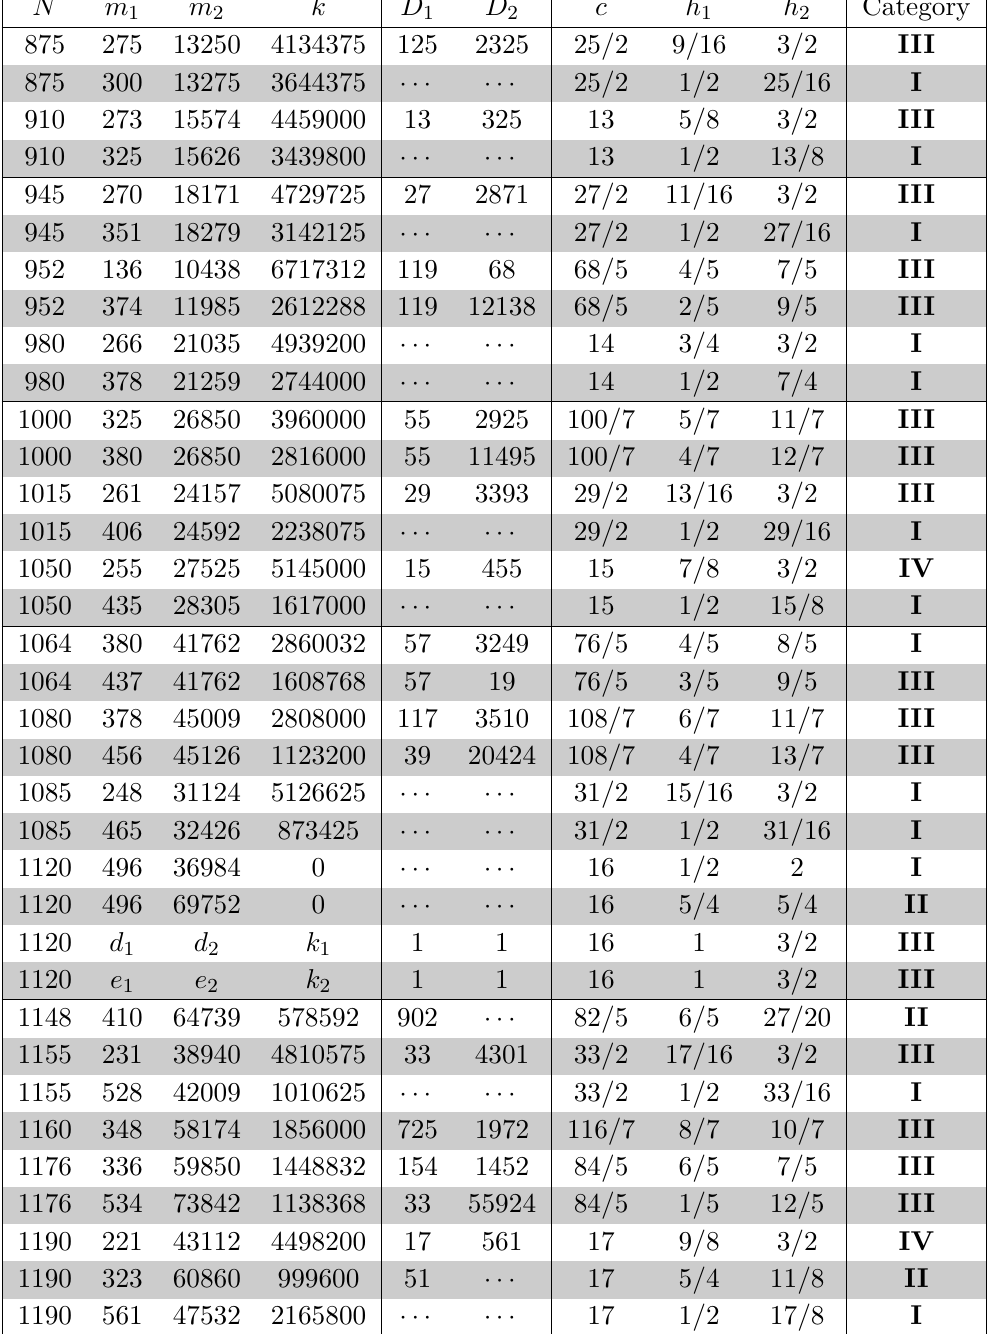
Table 13 . Solutions to the [ 3 , 0 ] MLDE with 12 < c ≤ 17